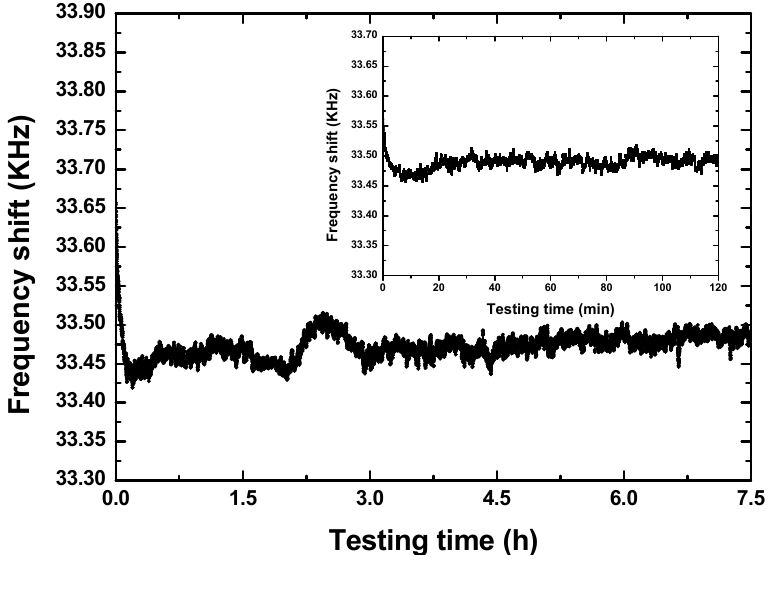
Figure 6. The measured long-term frequency stability of the fabricated SAW oscillator, insert: short-term frequency stability